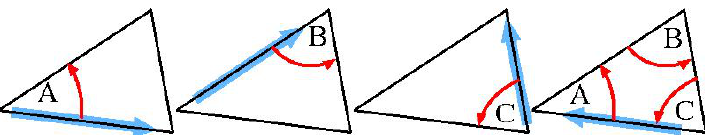
Figure 1. Mary Pardoe’s proof of the triangle sum theorem: rotating the arrow through angle A, then angle B, then angle C, produces a total rotation of half a revolution, i.e., 180 ◦ , and that feature of the diagram obviously does not depend on its size, shape, location, colour, etc, as long as the triangle is planar. Her pupils understood and remembered this more easily than the standard proof, using parallel lines and the parallel axiom. For discussion see http://www.cs.bham.ac.uk/research/projects/